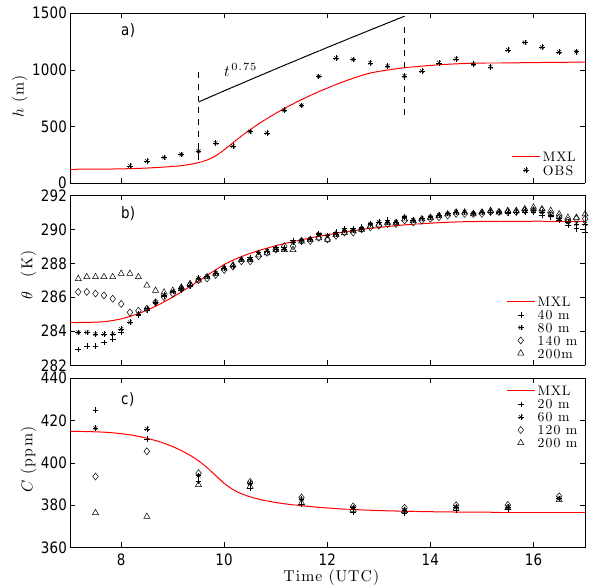
Fig. 2. Observed (symbols) and simulated by means of mixed layer model (red solid lines) diurnal evolution during 25 th September 2003 of (a) the boundary layer depth, (b) potential temperature and (c) CO 2 mixing ratio. The initial and prescribed values of the mixed layer simulation are presented in Table 1. As a reference, the evolution of the boundary layer depth following with t 0 . 75 is indicated by a black solid line. The vertical dashed lines are the boundaries between the different regimes explained in the